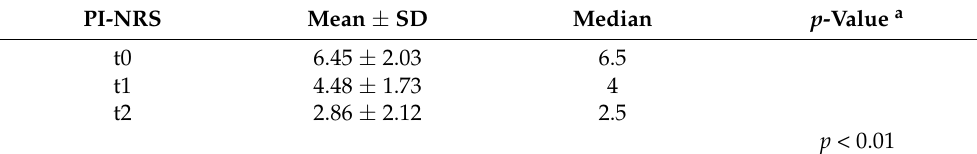
Table 1. Mean and Median of Group Test (42 subjects) at t0, t1 (4 months) and t2 (8 months).